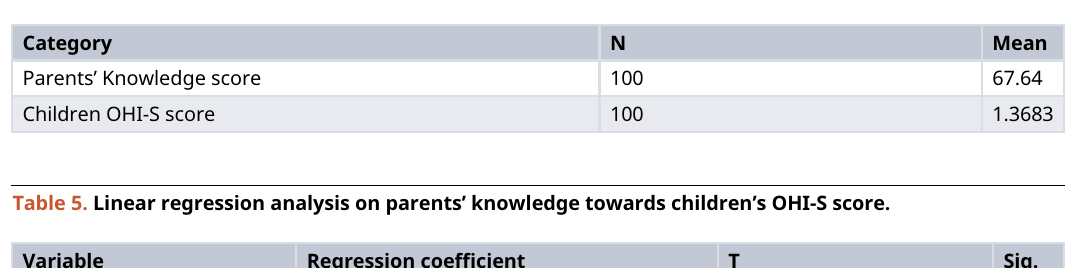
Table 4. The average parents ’ knowledge level and children with down syndrome ’ s (7-9 years old) OHI-S score in POTADS.